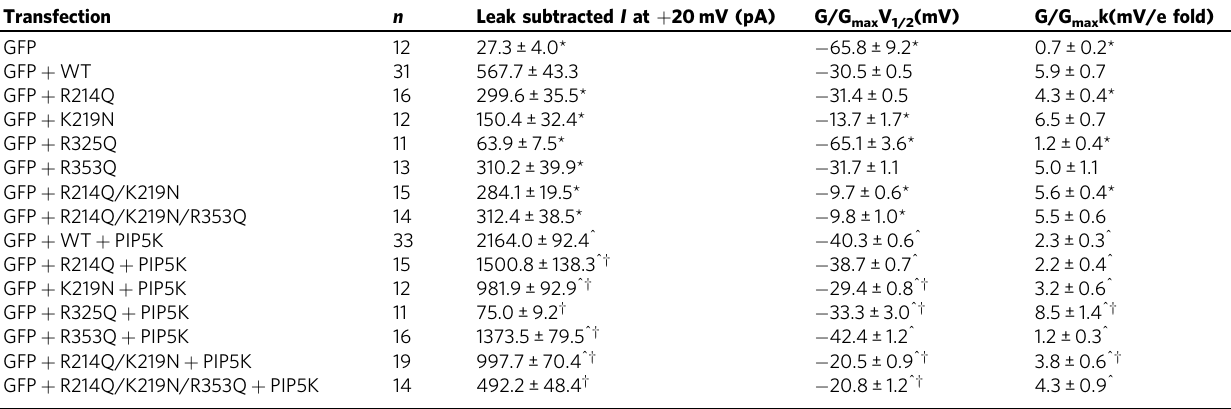
Table 2 Biophysical properties of K v 7.2 homomers in CHO hm1 cells co-transfected with GFP and PIP5K.